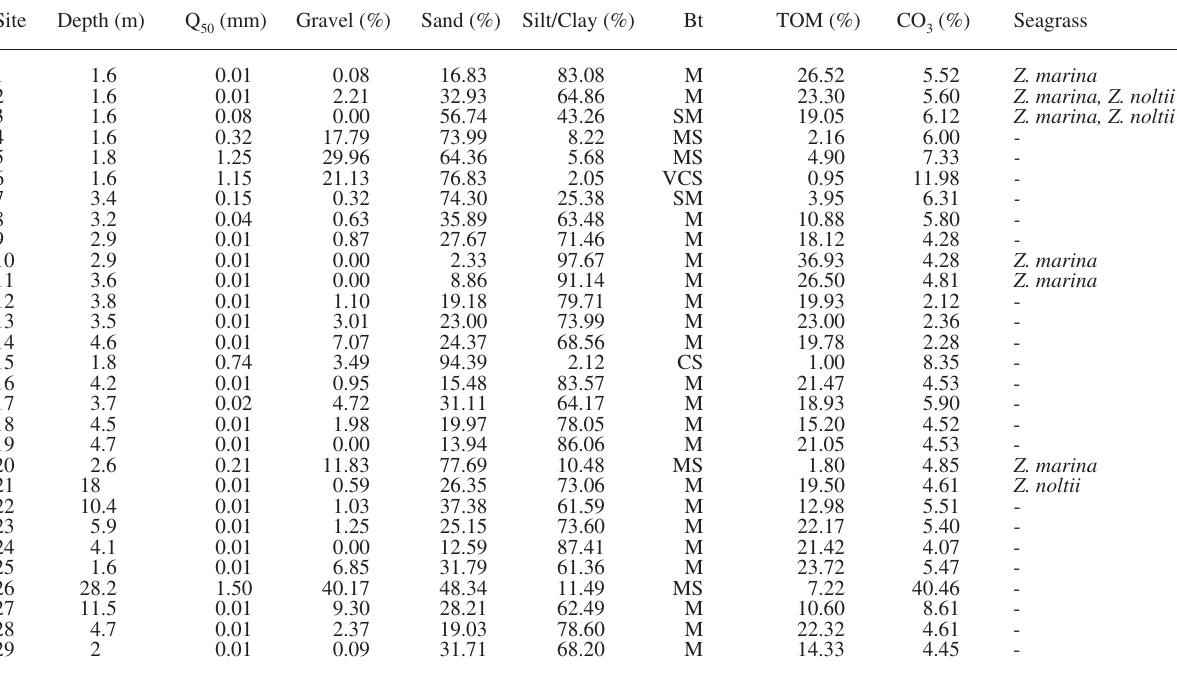
Table 1. – Depth (those under 2 m are intertidal sites sampled during high tide) and physical characteristics of sediments at each site: Q median particle size; bt, bottom type (M, mud; sM, sandy mud; Ms, muddy sand; vCs, very coarse sand; Cs, coarse sand); ToM, total organic matter and Co , calcium carbonate content. seagrass presence is cited in the last column. 3